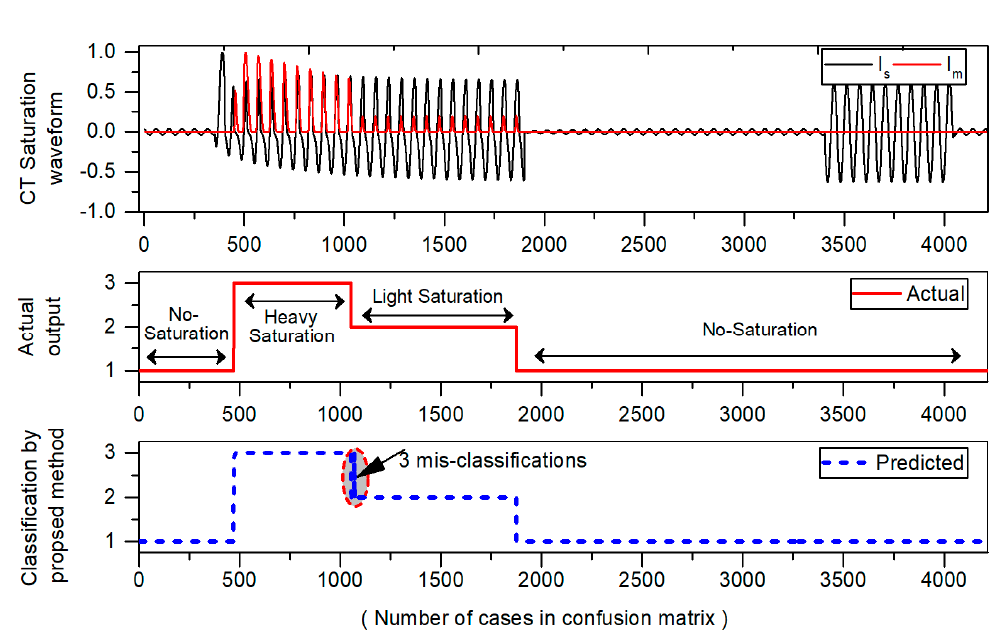
Figure 9. Waveform showing misclassifications of the confusion matrix. All misclassified cases are encircled with red color.